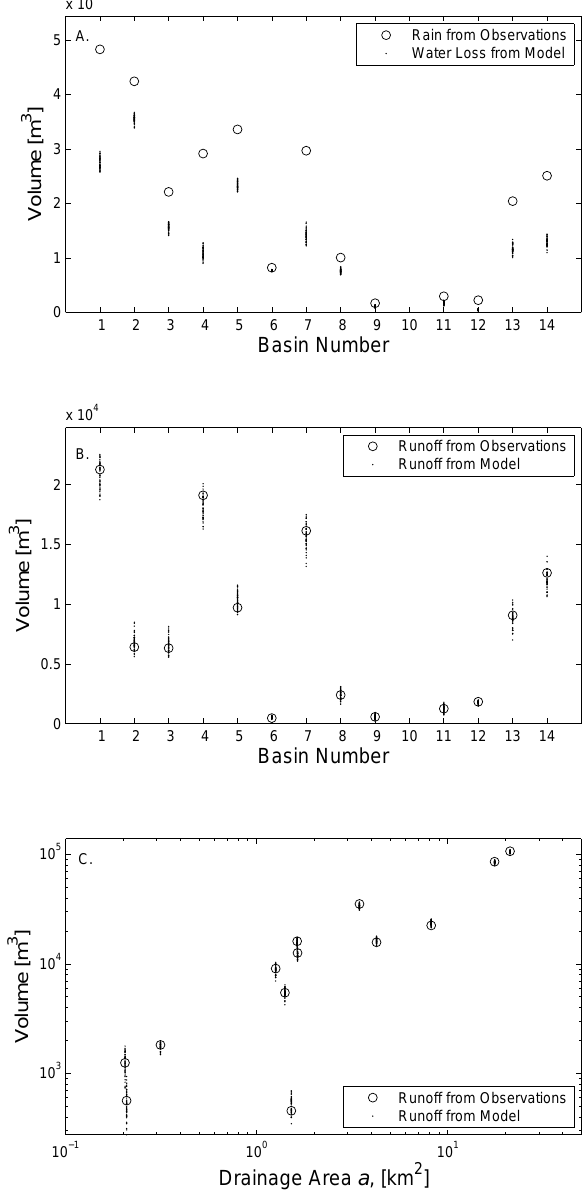
Fig. 11. Plot A shows the volume of observed rainfall and modeled water loss for each unnested basin. Plot B shows the volume of observed and modeled runoff for each unnested basin. On average, model realizations of runoff equal observed runoff. Plot C shows the log–log relationship between nested-basin runoff and upstream drainage area for both observations and model realizations. Note that runoff values do not include a baseflow component and thus are not equivalent to